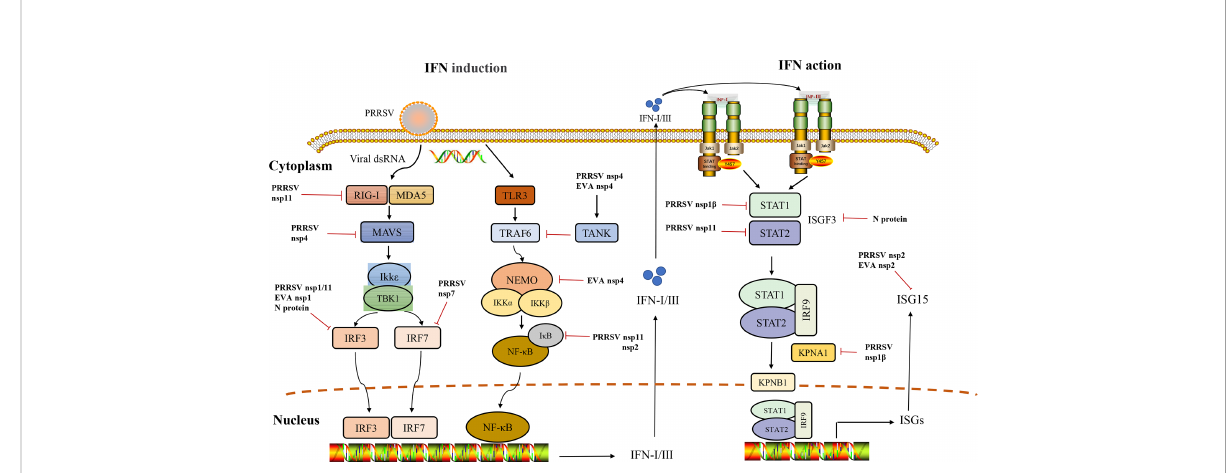
FIGURE 1 Interference of IFN induction and its downstream signaling pathway by